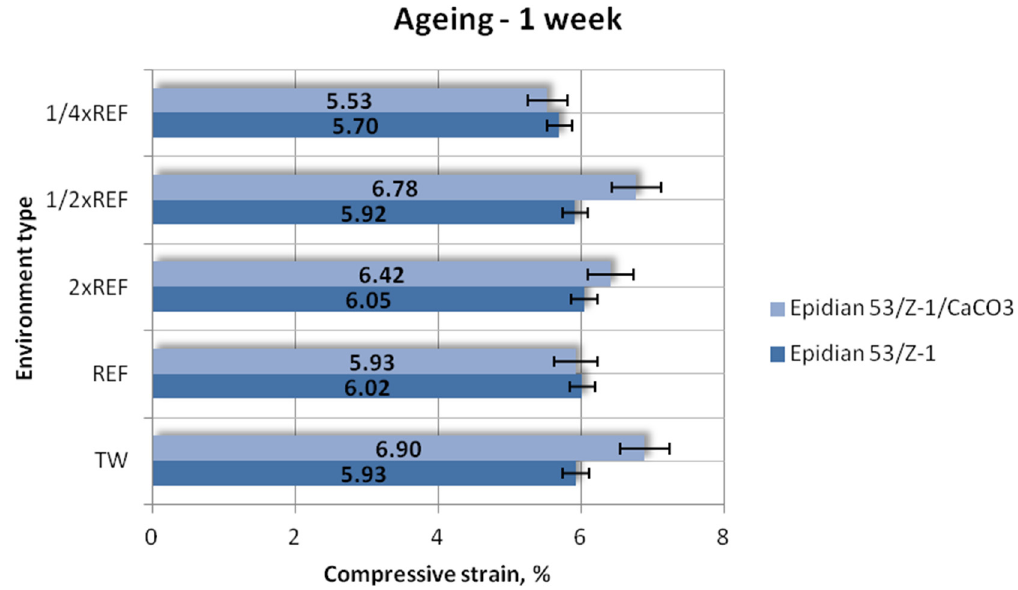
Figure 9. Compressive strain of the unmodified (Epidian 53 / Z-1) and modified (Epidian 53 / Z-1 / CaCO 3 ) epoxy adhesive compounds, aged for 1 week.